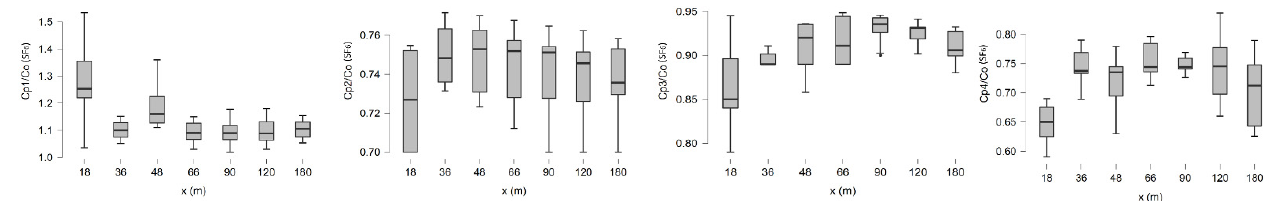
Figure 3. Cp/Co for SF 6 using the Raleigh 2006 NO experiment (Data 2) for stable atmospheric con- ditions concerning the downwind distances.